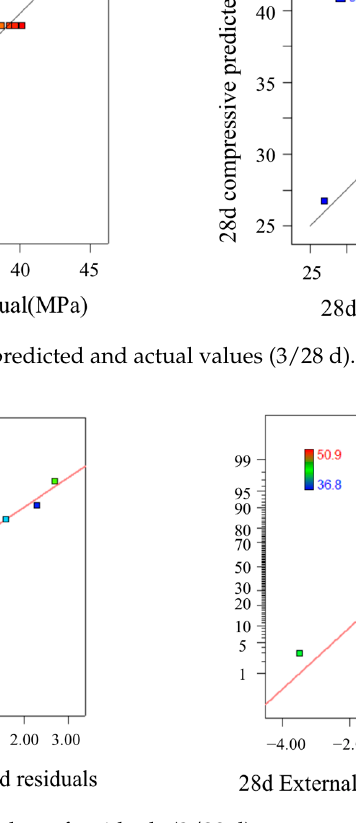
Figure 6. Plot of residuals against predicted response (3/28 d).